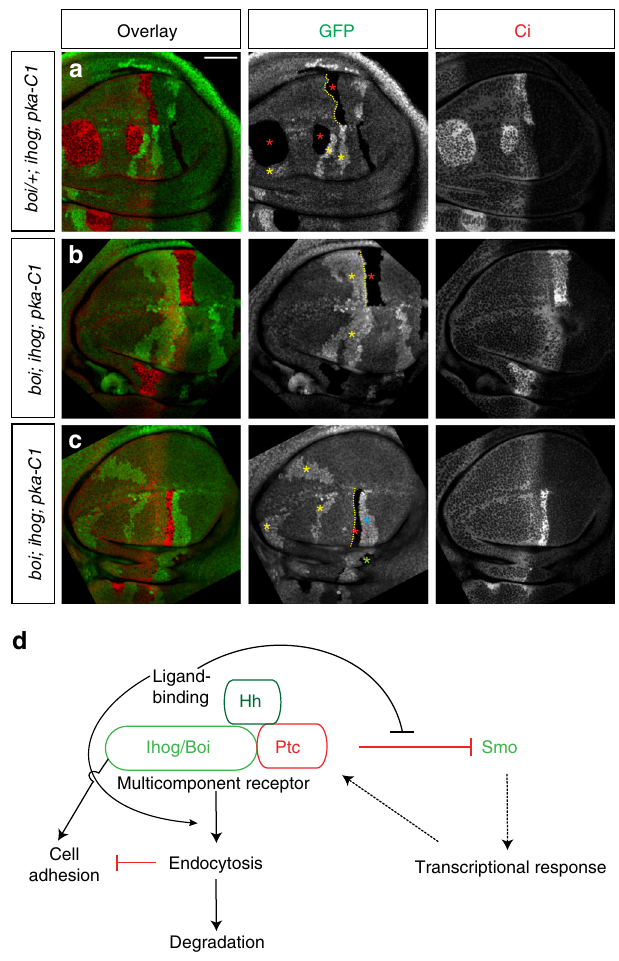
Fig. 8 Ihog contributes to AP cell segregation independent of their Hh receptor function. a – c Each set of panels shows a wing imaginal disc immunostained for GFP (green) and Ci (red). The mutant clones are marked by the absence of GFP expression (red asterisks), and the wild-type sister clones composed of cells that have two copies of GFP and thus are marked by elevated level of GFP expression (yellow asterisks). a pka-C1 mutant A cells (GFP negative, Ci positive, red asterisks) arising from A cells close the A/P boundary mix well with adjacent A cells (dashed yellow line showing a wiggly border). b pka-C1 loss failed to rescue the cell segregation defects of boi ; ihog mutant A cells (GFP negative, Ci positive, red asterisks). Note that boi ; ihog mutant cells form a sharp boundary (yellow line) with adjacent A cells (yellow asterisks). c Note that boi ; ihog pka-C1 triple mutant clones are absent in the A compartment away from the A/P boundary of the wing pouch even with the presence of three wild-type sister clones (yellow asterisks); these triple mutant clones typically accumulate in a large clone at the A/P boundary (see text). The boi ; ihog pka-C1 triple mutant clone originating in the posterior compartment of the wing pouch is indicated with a green asterisk and its wild-type sister clone is indicated by a blue asterisk. Scale bar, 50 µ m. d Schematic summary of Ihog protein activity. In the absence of Hh, Ihog/Boi interacts with Ptc to form a receptor that is presented on the cell surface 43 . When Hh ligand is present, it binds this receptor and blocks the inhibition of Smo by Ptc, thus permitting activation of downstream pathway components. Binding of the Hh ligand induces ligand:receptor internalization and degradation of the ligand: receptor complex, preventing further action of Hh on distant cells. Ligand- induced receptor clearance also creates a discontinuity in the Ihog protein levels at the A/P compartment boundary, which may contribute to